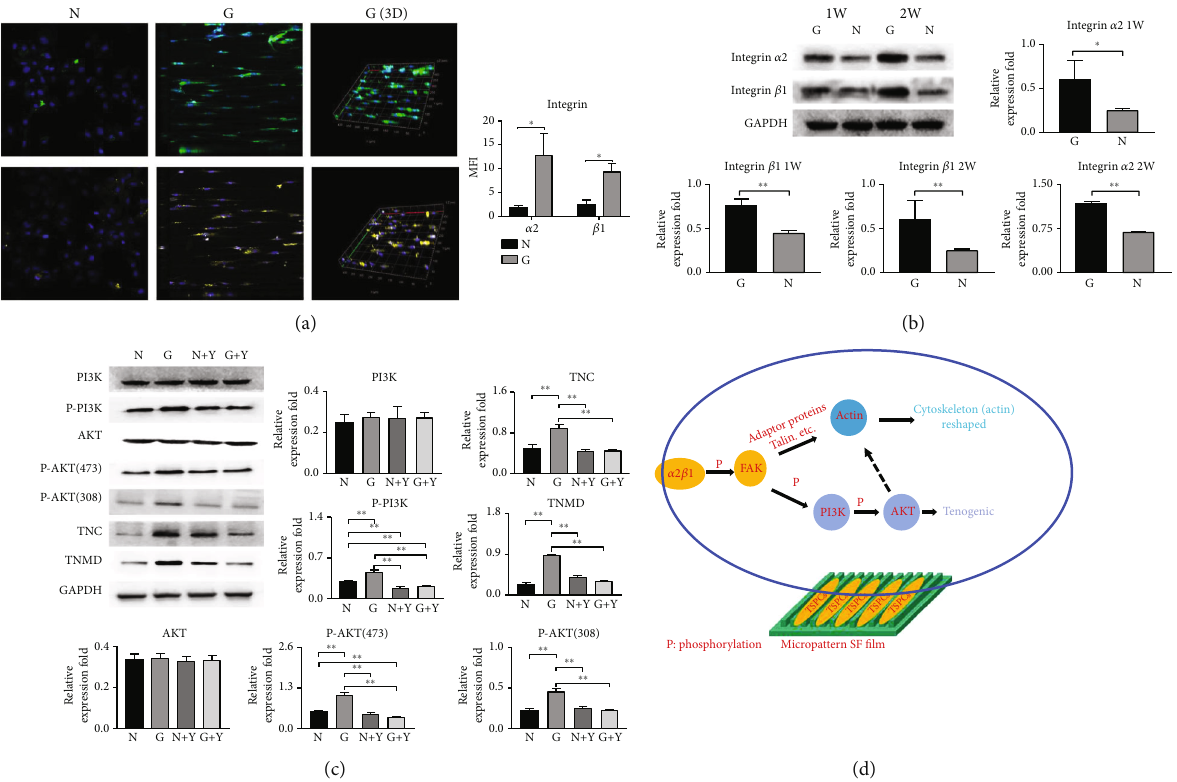
Figure 5: Validation of key proteins in signaling pathways. (a) Immuno fl uorescence results of α 2 β 1. The expression level of Group G was signi fi cantly higher than that of group N. (b) Western blot analysis of integrin α 2 β 1. α 2 β 1 was signi fi cantly increased in Group G. (c) Western blot analysis of the PI3K/AKT signaling pathway. The TNC, TNMD, and phosphorylated PI3K/AKT (p-PI3K, p-AKT308, and p-AKT473) were signi fi cantly increased in Group G. After adding PI3K/AKT pathway inhibitors, the expression of TNC and TNMD was inhibited simultaneously with phosphorylated PI3K and AKT. (d) Schematic diagram of the signaling pathway of micropattern SF fi lms regulating